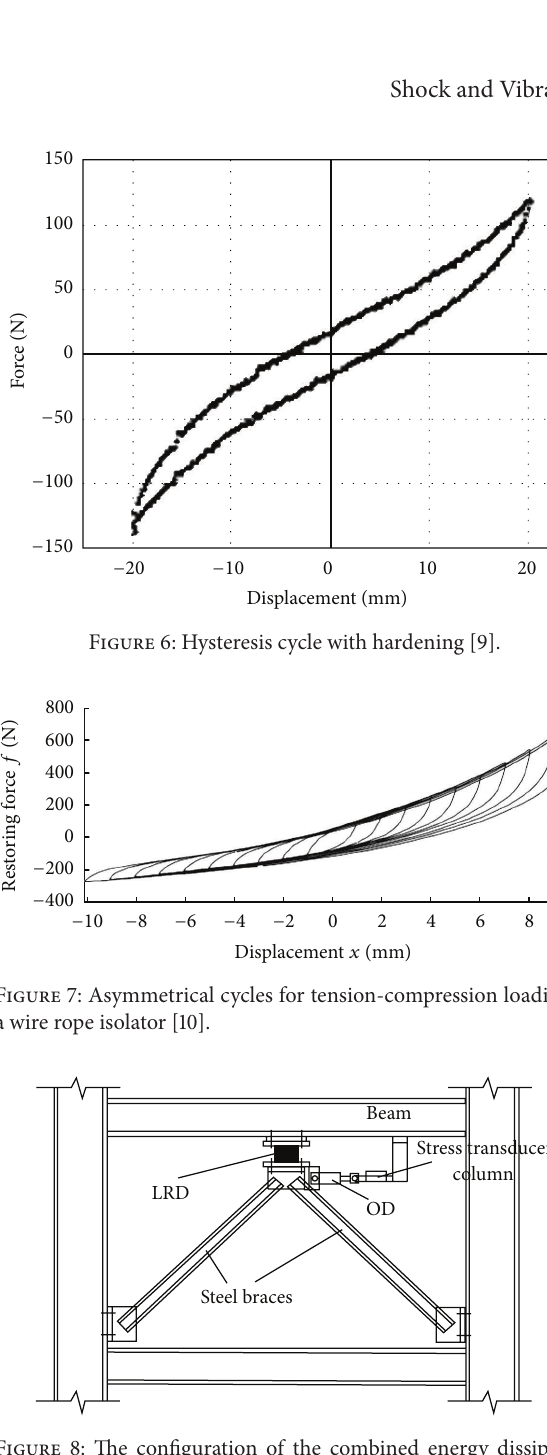
Figure 8: The configuration of the combined energy dissipation system in a frame [11].